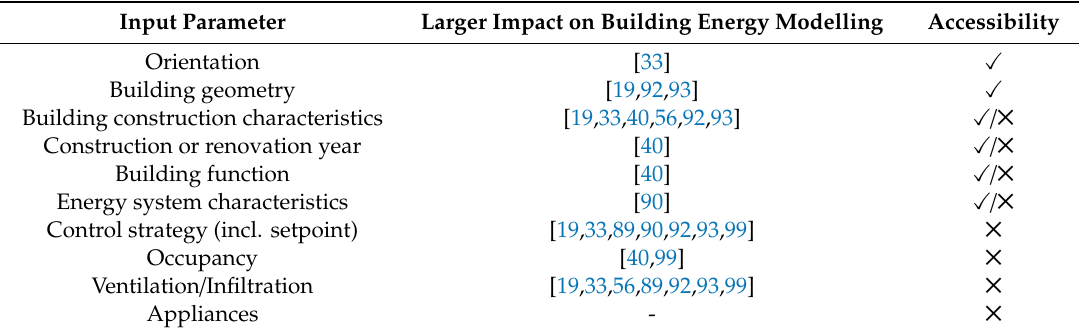
Table 2. Data impact and accessibility at urban